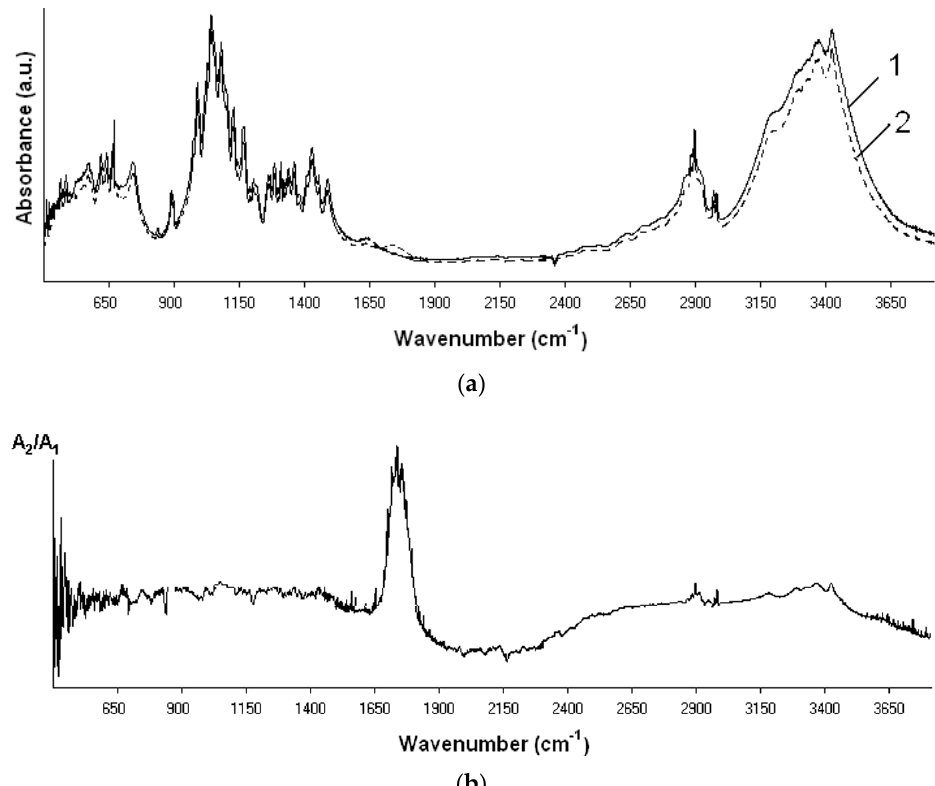
Figure 6. The IR-spectroscopy of cellulose: ( a ) The different IR-spectra of the cellulose before (1, A 1 ) and after the EBP-treatment (2, A 2 ) in oxygen media; ( b ) the ratio of the IR-spectra (A 2 /A 1 ).